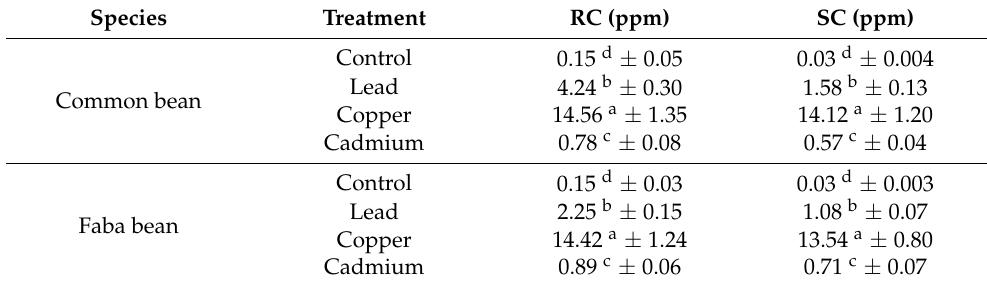
Table 3. Root and shoot concentration of bean and faba bean at the vegetative